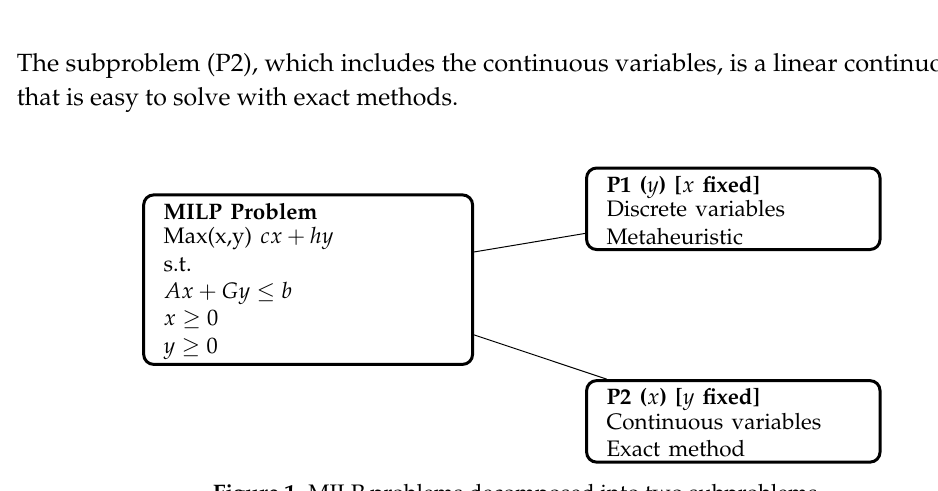
Figure 1. MILP problems decomposed into two